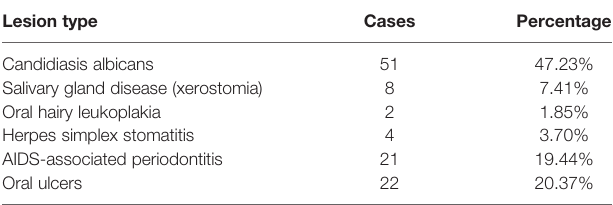
TABLE 3 | Oral lesions in HIV-infected